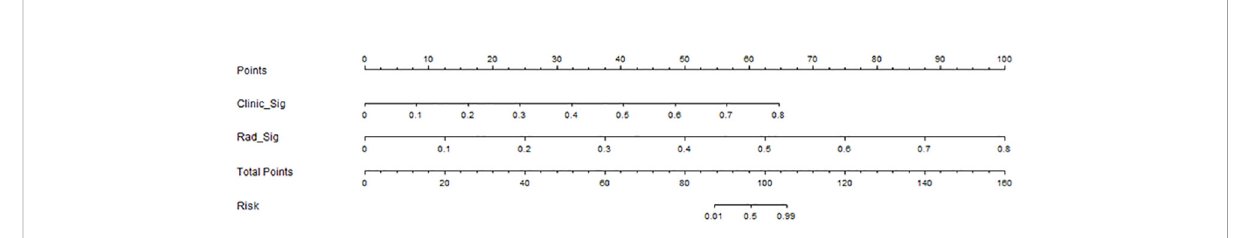
FIGURE 8 Clinical application of the nomogram in the differentiation of benign and malignant pulmonary